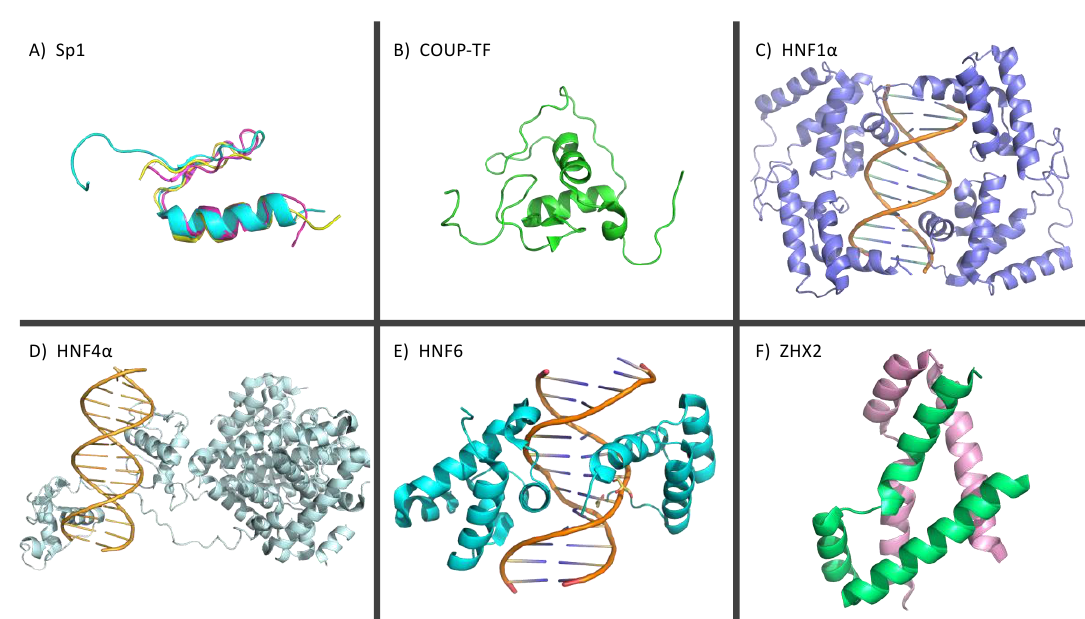
Figure 3. An overview of high-resolution structures of transcription factors. ( A ) An overlay of high-resolution structures of three zinc finger domains of Sp1 [53]. ( B ) A structure of COUP-TF zinc finger domain [pdb: 2EBL]. ( C , D ) High-resolution structures of HNF1 α [201] and HNF4 α [202] bound to the major groove of DNA. In both cases, cccDNA DNA sequences (5 (cid:48) -GTTAATNATTAAC-3 (cid:48) recognized by HNF1 α and 5 (cid:48) -CAGAGGNCAAAGTCCA-3 (cid:48) by HNF4 α ) were used to calculate 3 dimensional structures employing 3D-DART web server [203]. ( E ) High-resolution structure of mouse HNF-6 α DNA-binding domain bound, which is identical to human HNF-6 α DNA-binding, with transthyretin (TTR) promoter [204]. ( F ) Dimeric structure of homeodomain 2 of ZHX2 protein [205] .